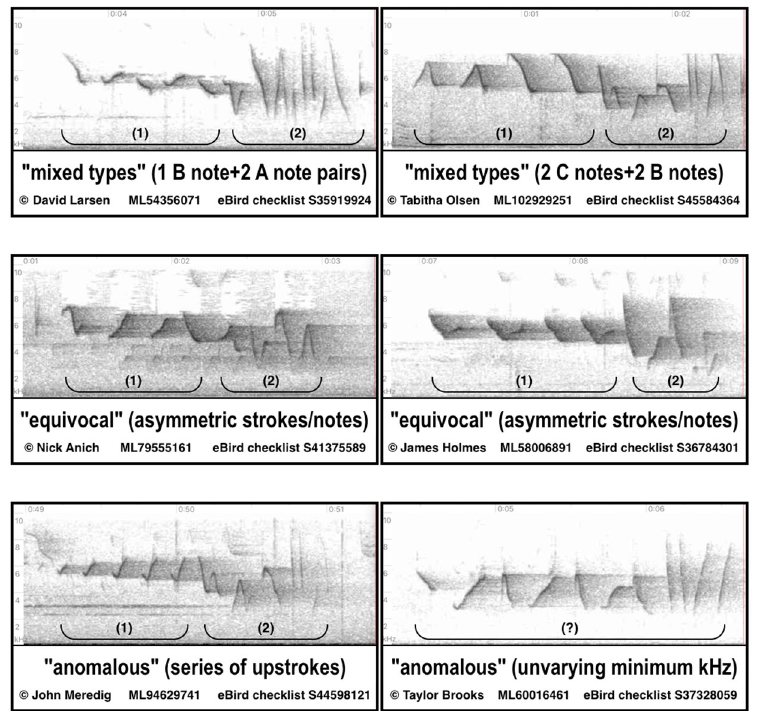
Fig 6. Spectrogram examples of unassigned songs. Two examples of each of the three subcategories of songs not readily assignable as Type A, B, or C have been selected from S1 Appendix. The analyzed introductory (1) and unanalyzed secondary (2) note sequences are designated by brackets; classifications are determined solely by the introductory note sequence when practicable.